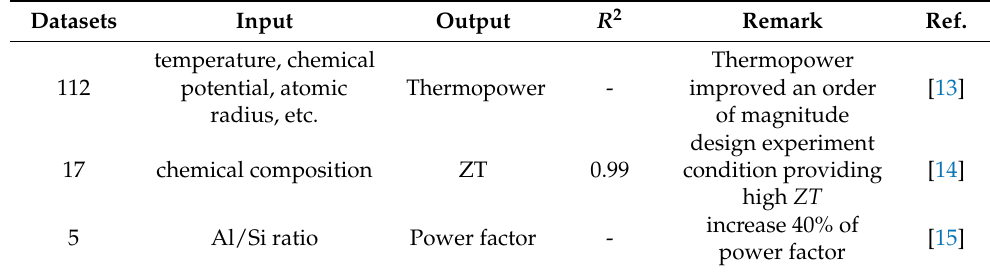
Table 1. Summary of the research investigating thermoelectric properties with ML.